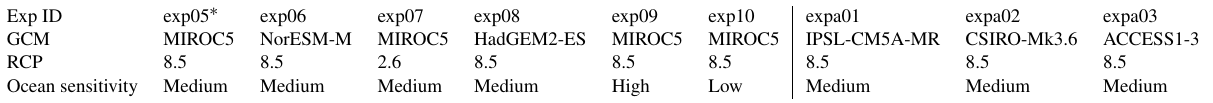
Table 1. List of GCM-forced experiments for ISMIP-Greenland projections. Climate model uncertainty is sampled with three core GCMs and three additional extended GCMs. Two different scenarios (RCP8.5, RCP2.6) are evaluated for model MIROC5. Sensitivity to the ocean forcing is sampled with three experiments under scenario RCP8.5. Forcing for the historical experiment is defined by each individual modeller (not shown). Experiment “ctrl_proj” applies zero SMB anomalies, no SMB-height feedback and a fixed retreat mask (not shown). Exp ID exp05 ∗ exp06 exp07 exp08 exp09 exp10 expa01